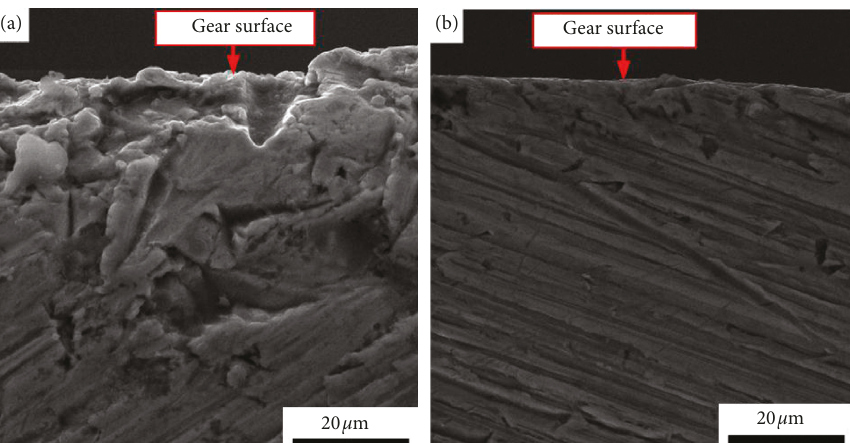
Figure 6: The gear surface after removing (a) the scale of the uncoated gear surface and (b) the coating of the coated gear surface.